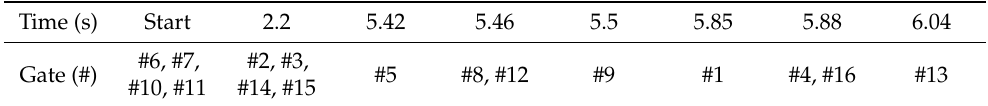
Table 3. Proposed sequence of filling valve